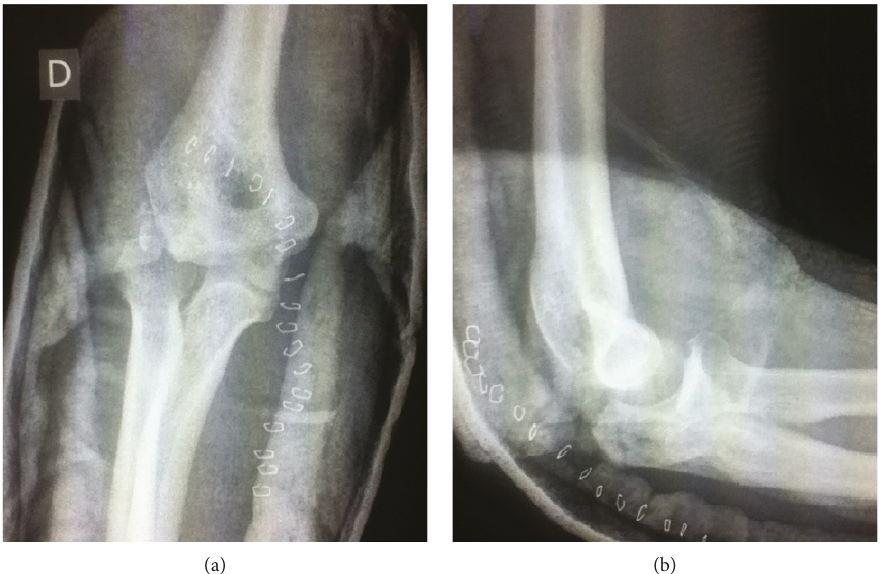
Figure 1: (a) Anteroposterior view of the elbow and (b) lateral view of the elbow following surgical debridement and partial olecranon excision.